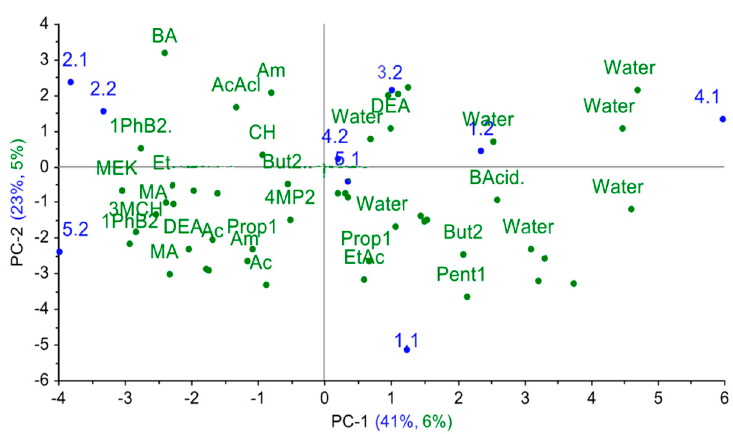
Figure 9. The results of the projection of the spectra of the cross mass-sensitivity parameters for individual substances on the PCA model for nasal swab samples. individual substances on the PCA model for nasal swab